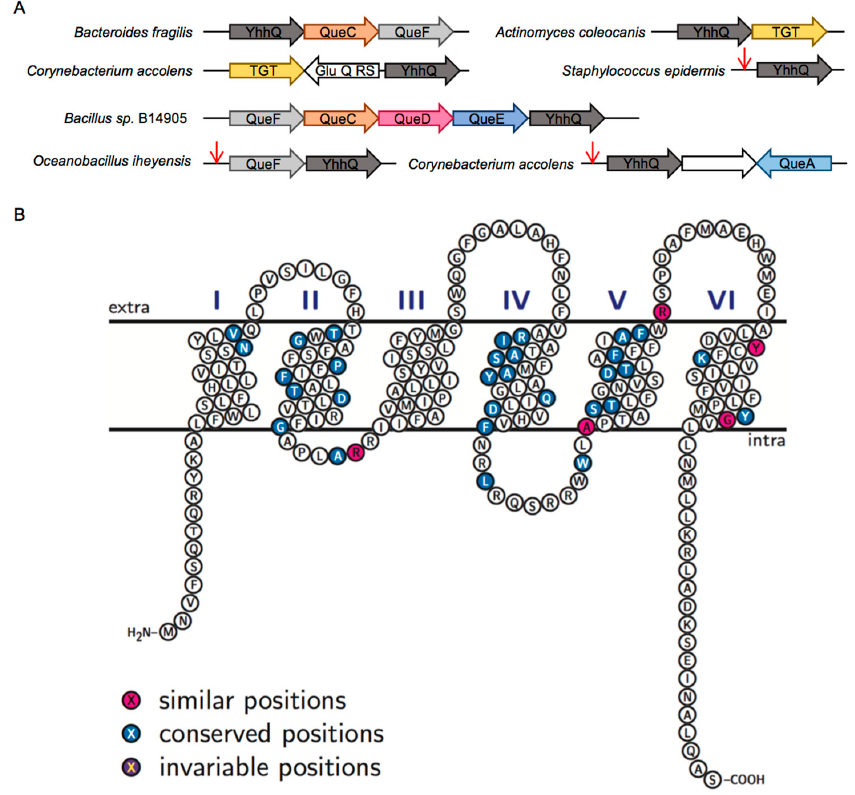
Figure 2. Bioinformatic analysis of YhhQ. ( A ) YhhQ is often found encoded on the genome close to Queuosine related genes. Red arrows represent preQ 1 ‐ responsive riboswitches. GluQ ‐ RS is a Glutamyl queuosine ‐ tRNA synthetase that produces a hyper modification of Queuosine [40]; ( B ) schematic representation of Escherichia coli YhhQ (P37619) illustrating the presence of the six proposed transmembrane domains, with standard identity and similarity shading, based on a sequence alignment of sequences defining the COG1738 group (Figure S2 for alignment). Image produced with TexTopo, with information from the P37619 Uniprot entry. Conserved position: ≥ 50%